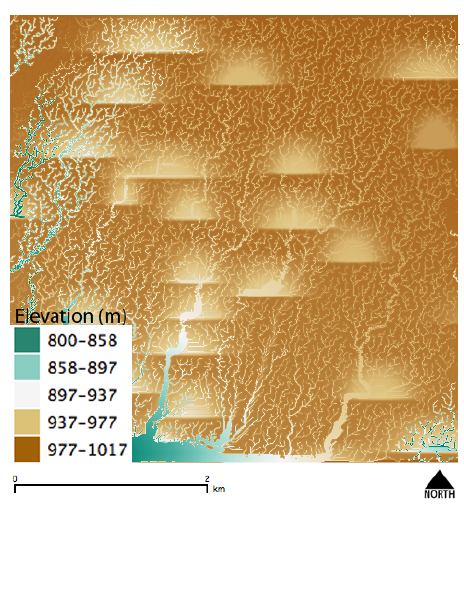
Figure 1. The synthetic Digital Elevation Model (DEM) that is the result of landscape evolution algorithm created using set river incision and different uplift rates across tectonic faults. The drainage system adapts to the evolving surface